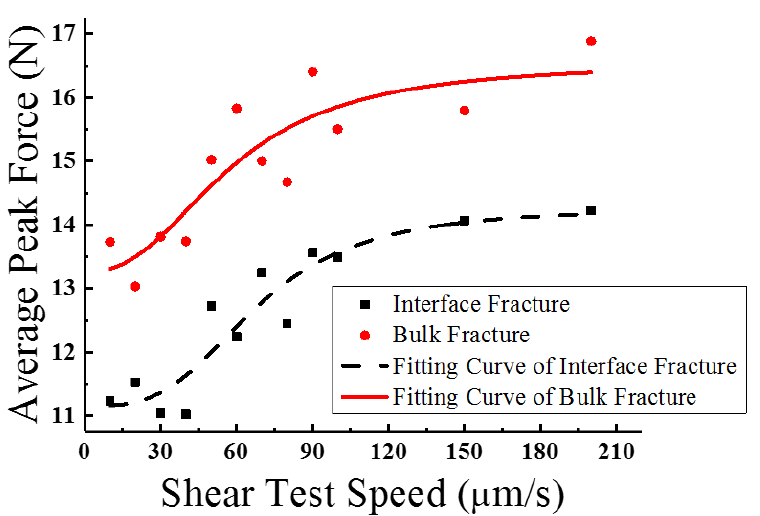
Figure 9. Average peak force distributions and fitting curves for the two fracture modes.